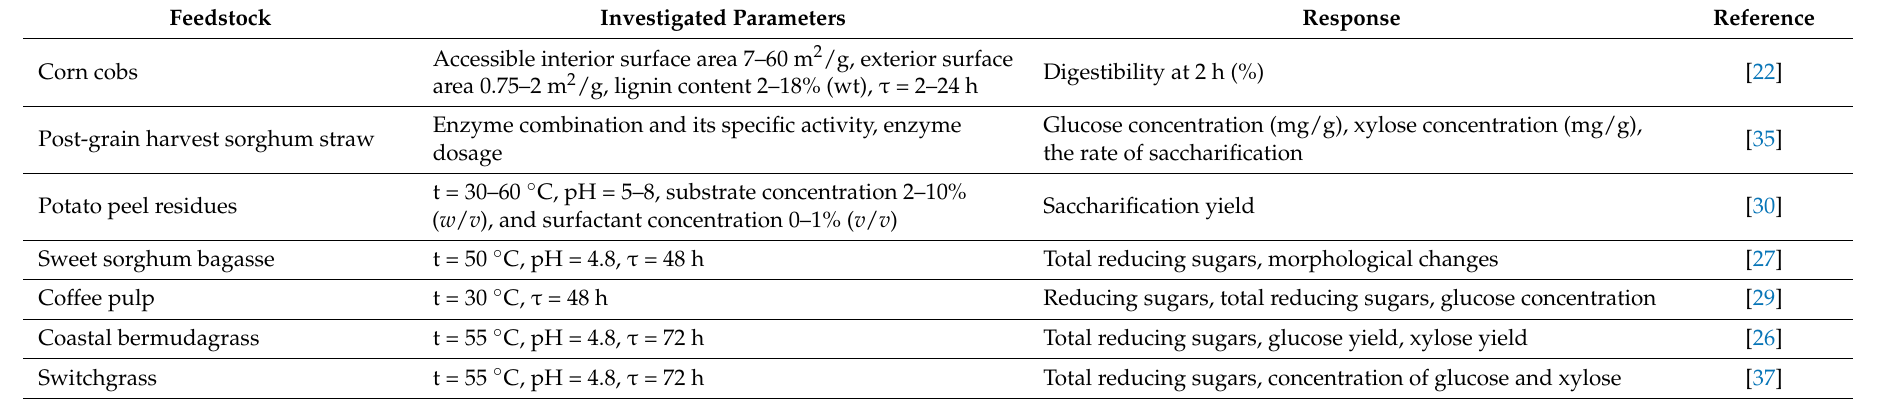
Table 2. Selected research on enzymatic hydrolysis of alkaline pre-treated lignocellulosic